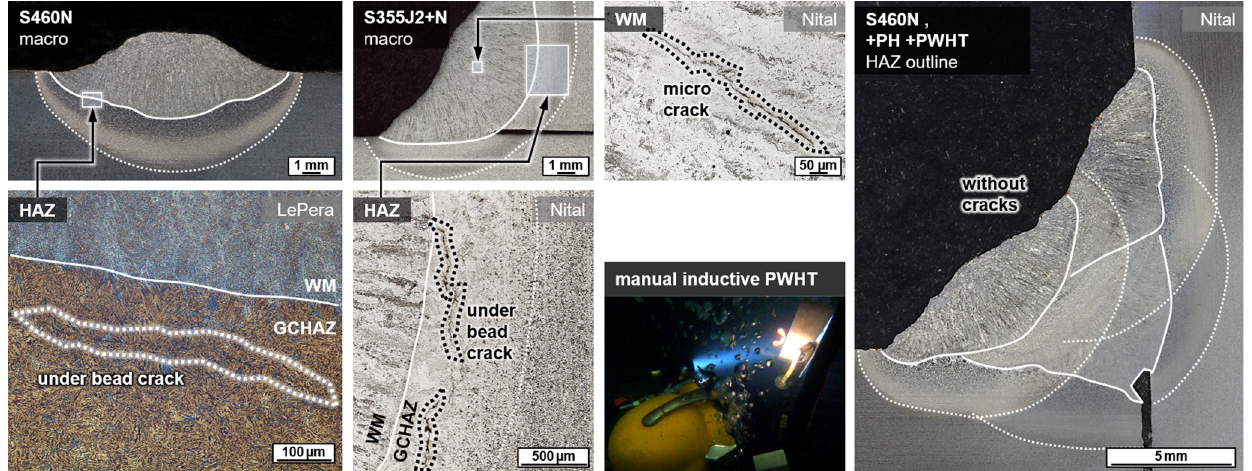
Figure 7. Exemplary occurrence of cold cracks in underwater welds at WD = 0.5 m for bead-on-plate ( left ) and fillet weld ( middle ) and positive effect of induction heating in multi-layer wet SMAW of a fillet weld without cracks ( right ).